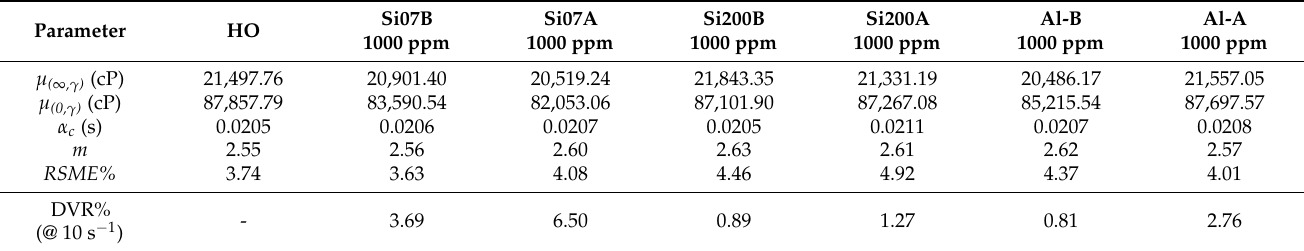
Table 5. Estimated parameters of the Cross rheological models for crude oil in the presence of Si07, Si200 and Al nanoparticles after surface modification processes at 1000 mg/L and 25 ◦